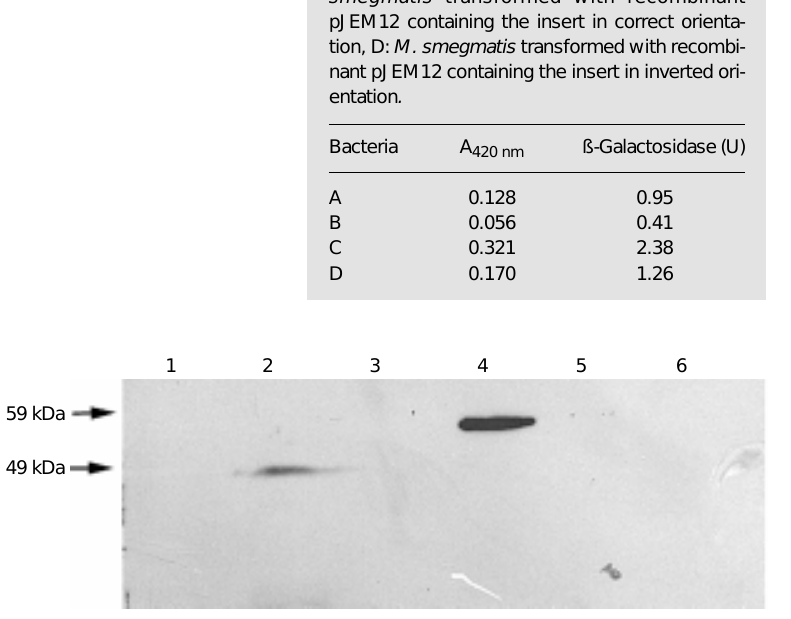
Figure 3 - Immunoblotting with anti-PLC-a serum. Lane 1 , Four-week M. tuberculosis culture supernatant; lane 2 , M. tuberculosis whole cell extract; lane 3 , M. bovis whole cell extract; lane 4 , recombinant PLC-a; lane 5 , M. avium whole cell extract, and lane 6 , M. smegmatis whole cell